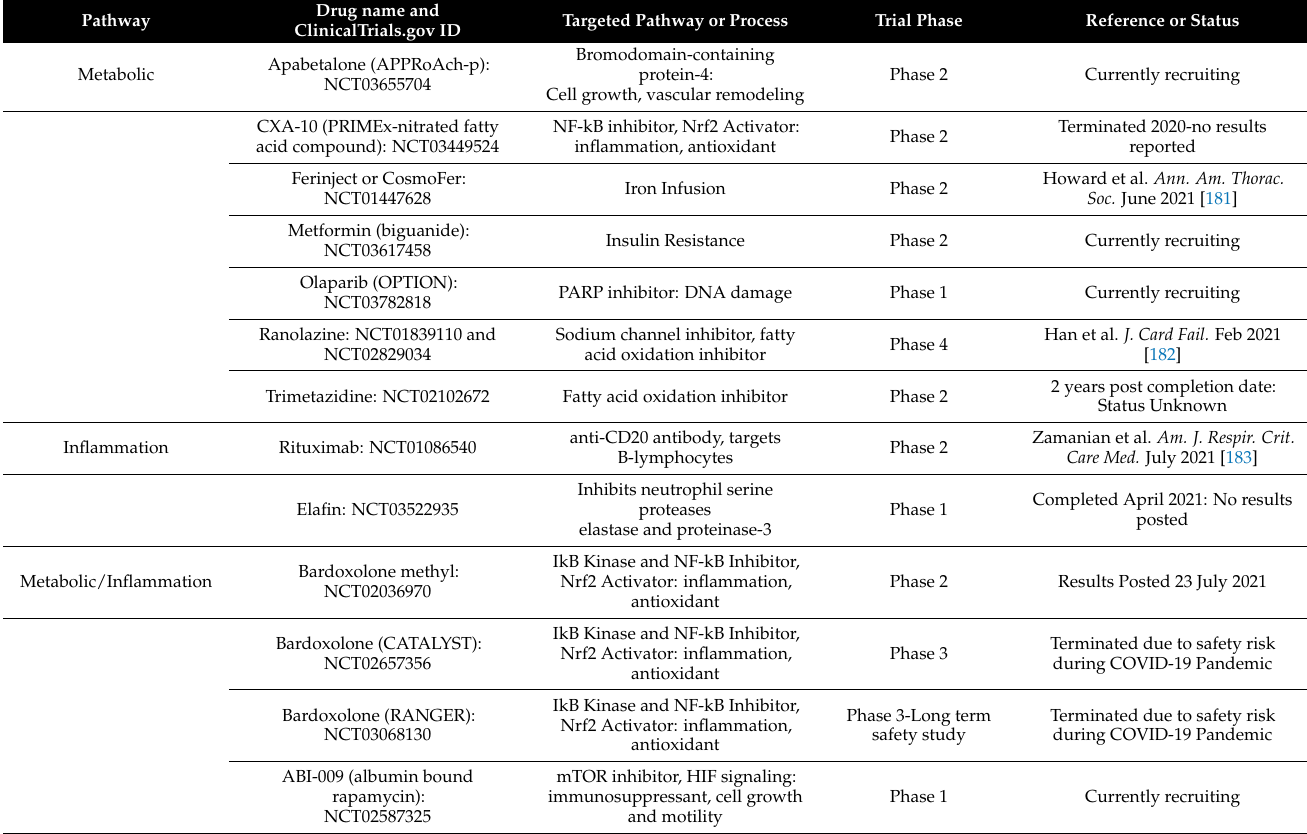
Table 1. Current PAH Clinical Trials Targeting Metabolic and Inflammation